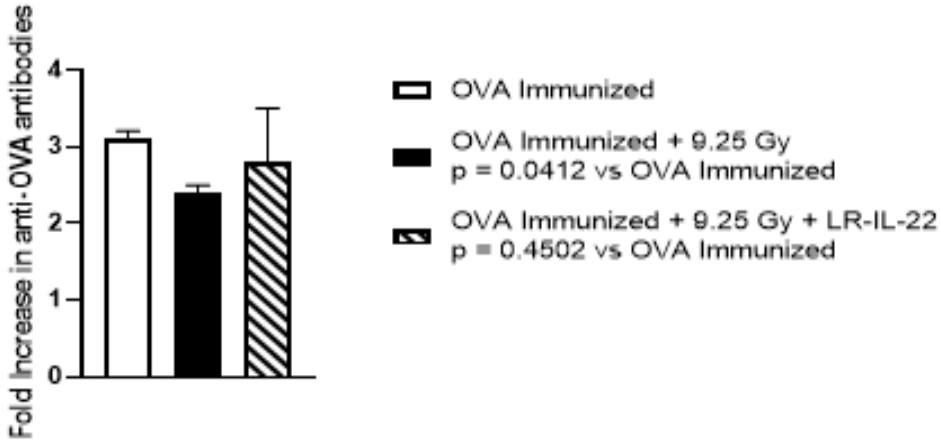
Figure 7. LR-IL-22 stimulates recovery of immunologic function after TBI. C57BL/6NTac mice ( n = 5 mice per group) were immunized with OVA and the antibody response was determined by ELISA at day 30 and at day 60 following immunization. Following a positive detectable antibody response to OVA on Day 60 after immunization the mice were then irradiated to 9.25 Gy TBI. At 24 after irradiation, a subgroup of mice was gavaged with LR-IL-22. On day 7 after irradiation the mice that had been irradiated were challenged with OVA. At day 11 after irradiation, the mice that had been challenged on day 7 were tested for the antibody response. Irradiation only mice had a significant decreased antibody response compared to OVA immunized mice (* p = 0.0412) while mice treated with gavage of LR-IL-22 had an antibody response similar to the OVA immunized only mice ( p = 0.4502). Bar graphs represent mean + standard error of the mean.